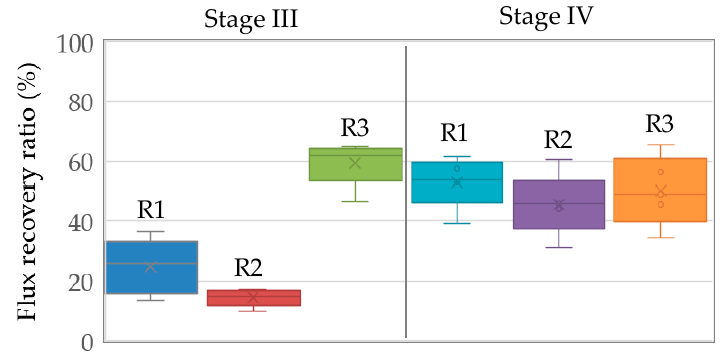
Figure 5. The permeate flux recovery by periodical chemical cleaning. In Stage III (30 min of cleaning duration), the permeate flux recovery ratios in R1, R2, and R3 were averaged at ~24.8%, ~14.4%, and ~59.5%, respectively. It was thought